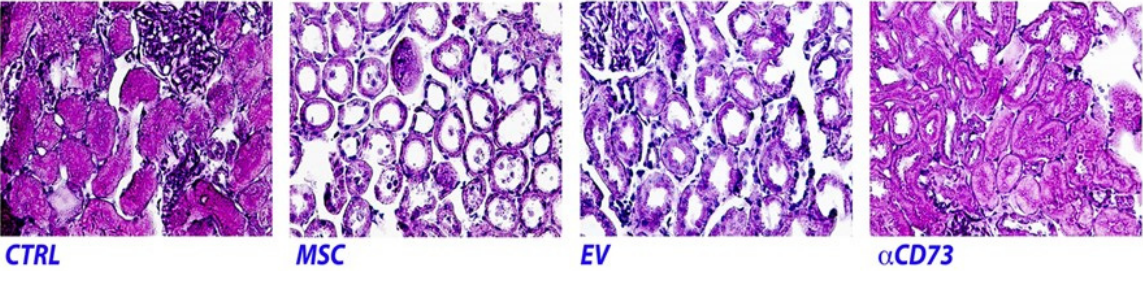
Figure 7. Global renal ischemic damage score. Top: Renal morphology. Periodic acid-Schiff stain- ing of representative renal sections from the CTRL, MSC, EV, and α CD73 groups (at ×10 magnifica- tion). Bottom: Columns representing the global ischemic damage score (GRS) expressed as mean and 95% confidence interval (** p < 0.01; **** p < 0.0001). CTRL, control group; MSC, mesenchymal stromal cell group; EV, extracellular vesicle group; α CD73, CD73-silenced group. N= 20 sections from each kidney were analyzed. 2.6. Interrelationship between Tissue and Effluent Purines We found an inverse correlation between the ATP content and ADO content in the tissues in all groups (r = − 0.90; p < 0.01) and a direct correlation between the ADO/ATP ratio in the effluent and the ATP/ADO ratio in the tissues in all groups (r = 0.94; p < 0.001; Figure 8A,B).